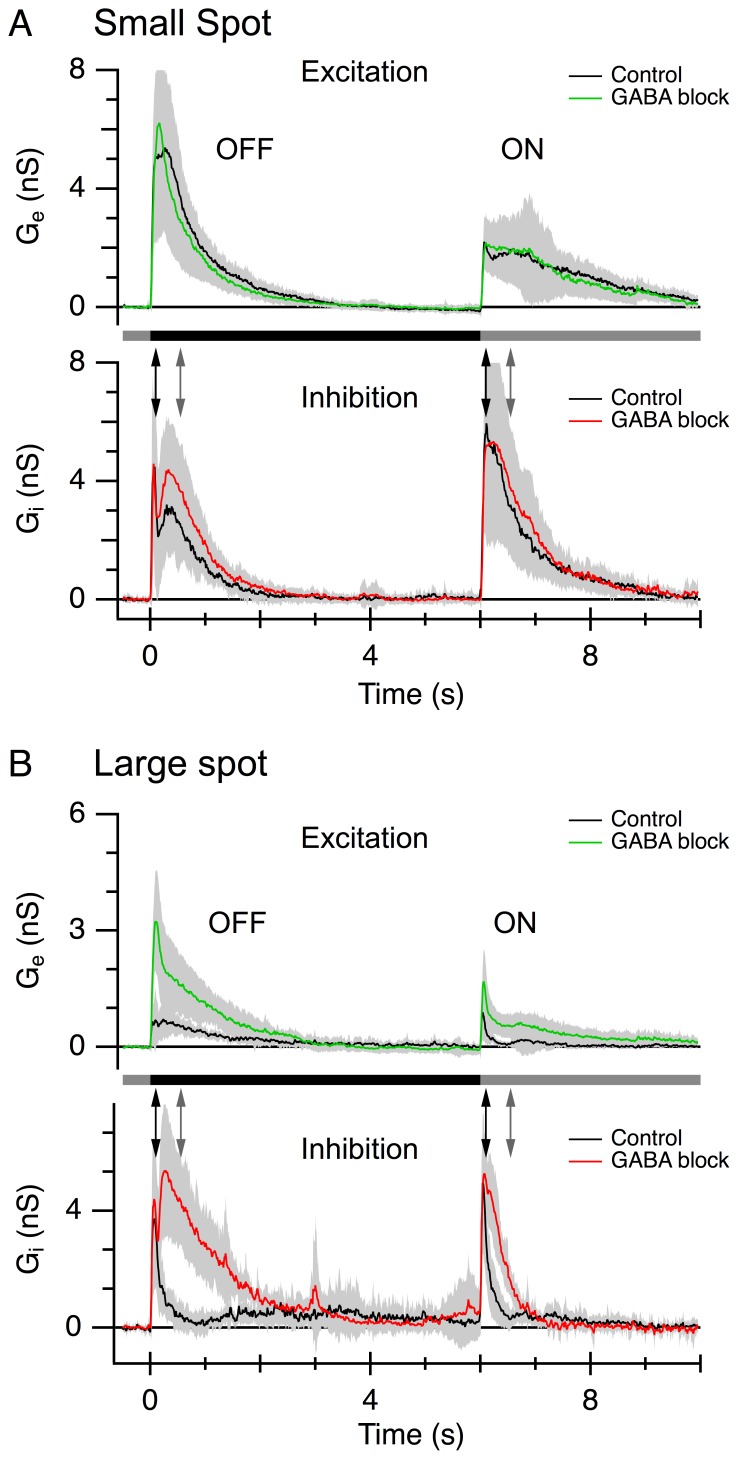
Surround suppression of both excitatory and inhibitory inputs is relieved by GABAergic antagonists.The stimulus was a 100 µm diameter dark spot (A) or a 850 µm diameter dark spot (B) centred in the receptive field; the stimulus timing is shown by the bars. Traces show the average conductances from 7 cells. Control responses are shown in black. The corresponding conductances in the presence of GABAergic blockers (30 µM TPMPA and 10 µM SR-95331) are shown in green for excitation and red for inhibition. Shading shows the standard deviation. The arrows show the early and late time-points used for comparison of the response amplitudes.